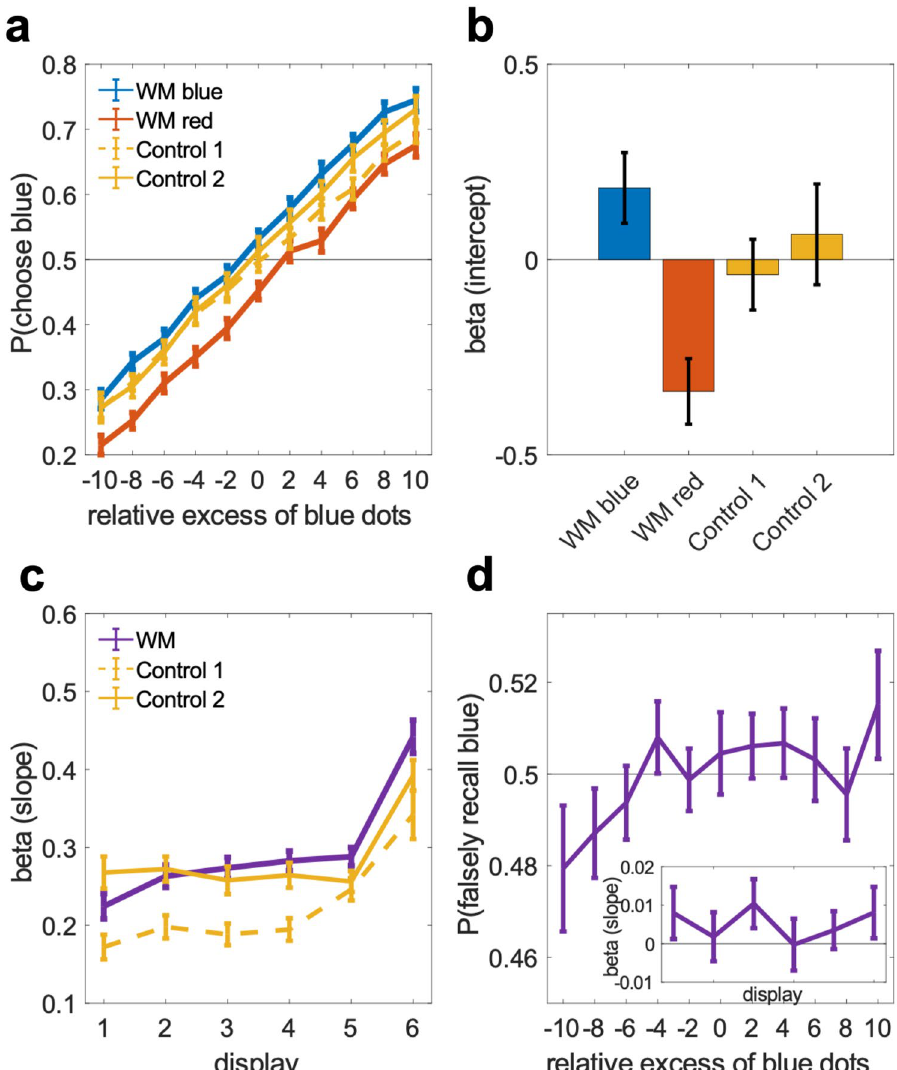
Figure 4. Bidirectional biases of WM and perceptual decisions—color information. ( a ) Psychometric weighting functions averaged over the six displays in the decision task, plotted separately for trials where the concurrently maintained WM sample was red or blue, and for control conditions without a concurrent WM task (cf. Fig. 1). ( b ) Bias terms (intercepts) derived from logistic regression of choice. ( c ) Choice sensitivity (slopes) to the red- blue dot composition in each of the six displays in the decision stream. ( d ) Memory recall bias. Probability of (erroneous) blue/red report in WM recall as a function of the blue-red composition of the intervening decision displays. Small inset plot shows the time-course of this relation over the six stream displays in terms of logistic regression coefficients. Error bars in all panels show standard error of the